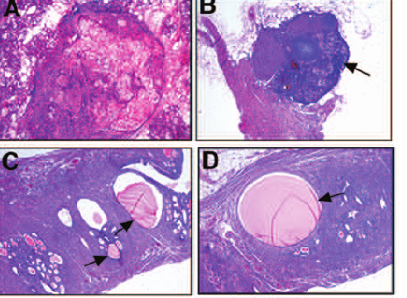
Figure 2. Mammary gland, ovary, pituitary and uterine anomalies. Representative H&E stained sections of mammary gland (A), ovary (B), and uterus (C & D). Focal nodules of squamous metaplasia were rarely observed in mammary sections of aged-multiparous mice (A), 10 6 magnification. Ovary anomalies occur frequently in the aged- multiparous mice, ovarian atrophy (panel B, arrow) was common in aged-multiparous mice, 5 6 magnification. Large fluid containing cysts suggestive of hydrometra (panel C arrow) and multiple smaller cysts were common in the uterus of aged-nulliparous females (panel D arrow), 5 6